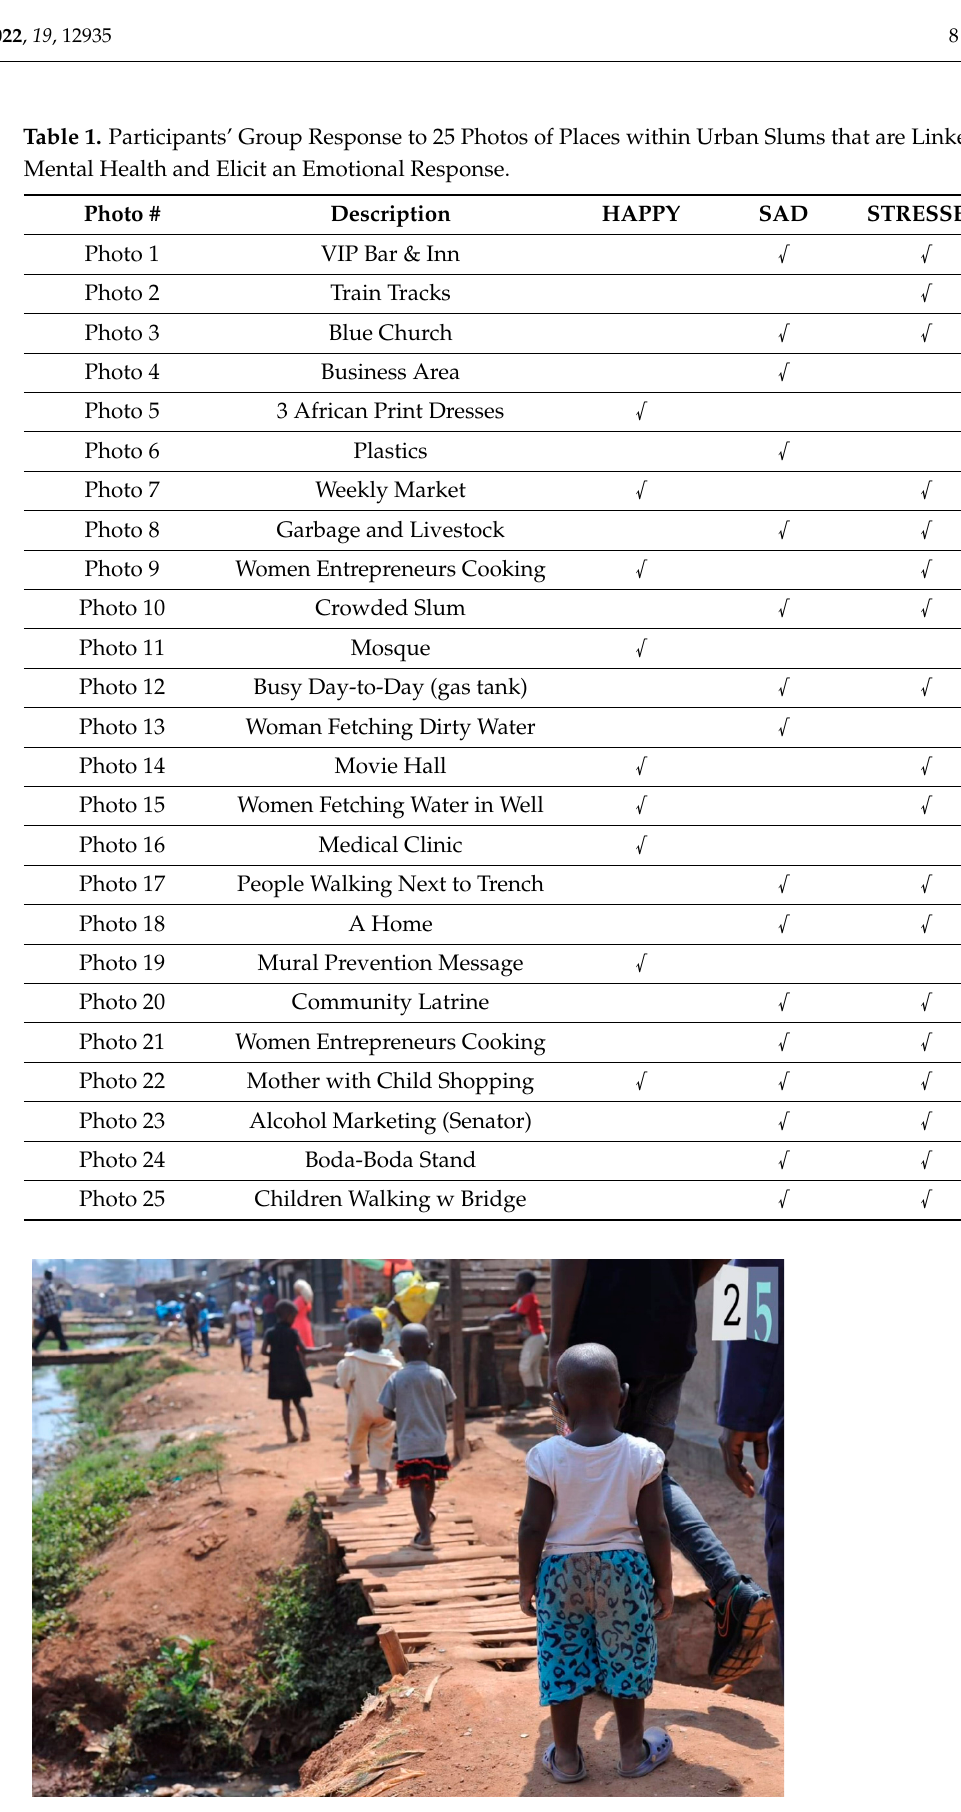
Figure 3. Children Walking over Bridge (photo number 25). Four photos reflected multiple emotional responses of happy and sad, and depicted the weekly market, women entrepreneurs cooking, women fetching water in a well (Fig- ure 4), and a movie hall for entertainment.